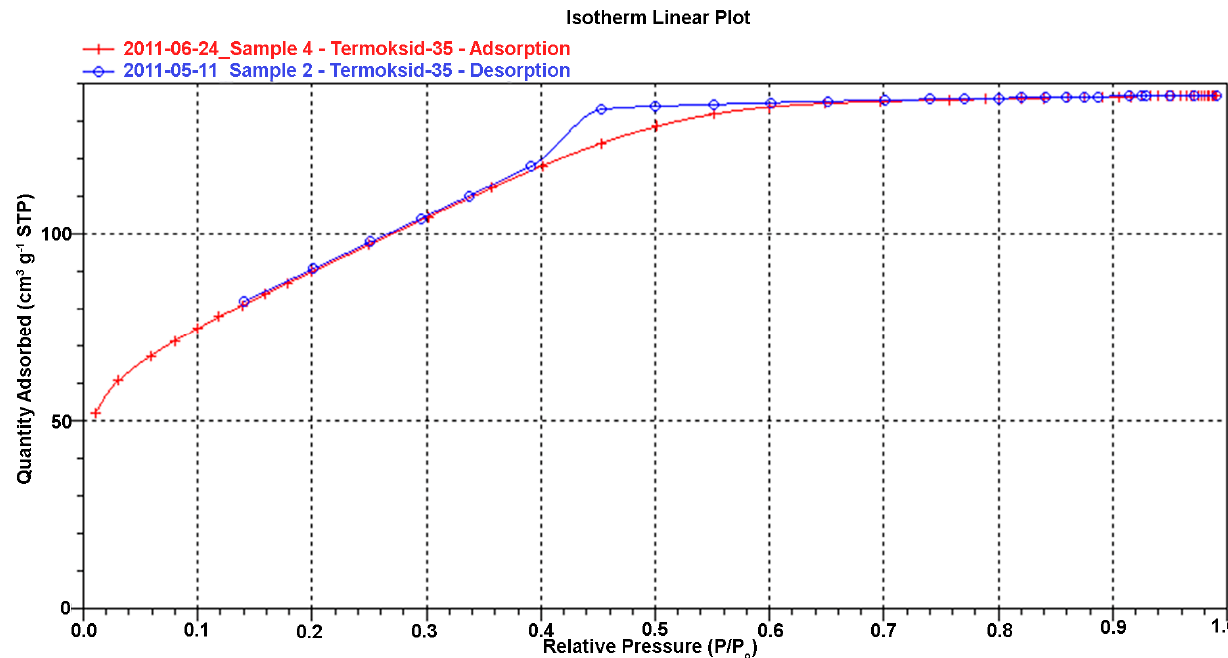
Figure 7. Nitrogen (N 2 ) adsorption/desorption isotherms of Termoksid-35 sorbent. X -axis is the p/p o —the relative pressure of the nitrogen gas; p o is the saturated gas pressure, Pa; Y -axis is the amount of adsorbed nitrogen gas, cm 3 g −1 of the sorbent.